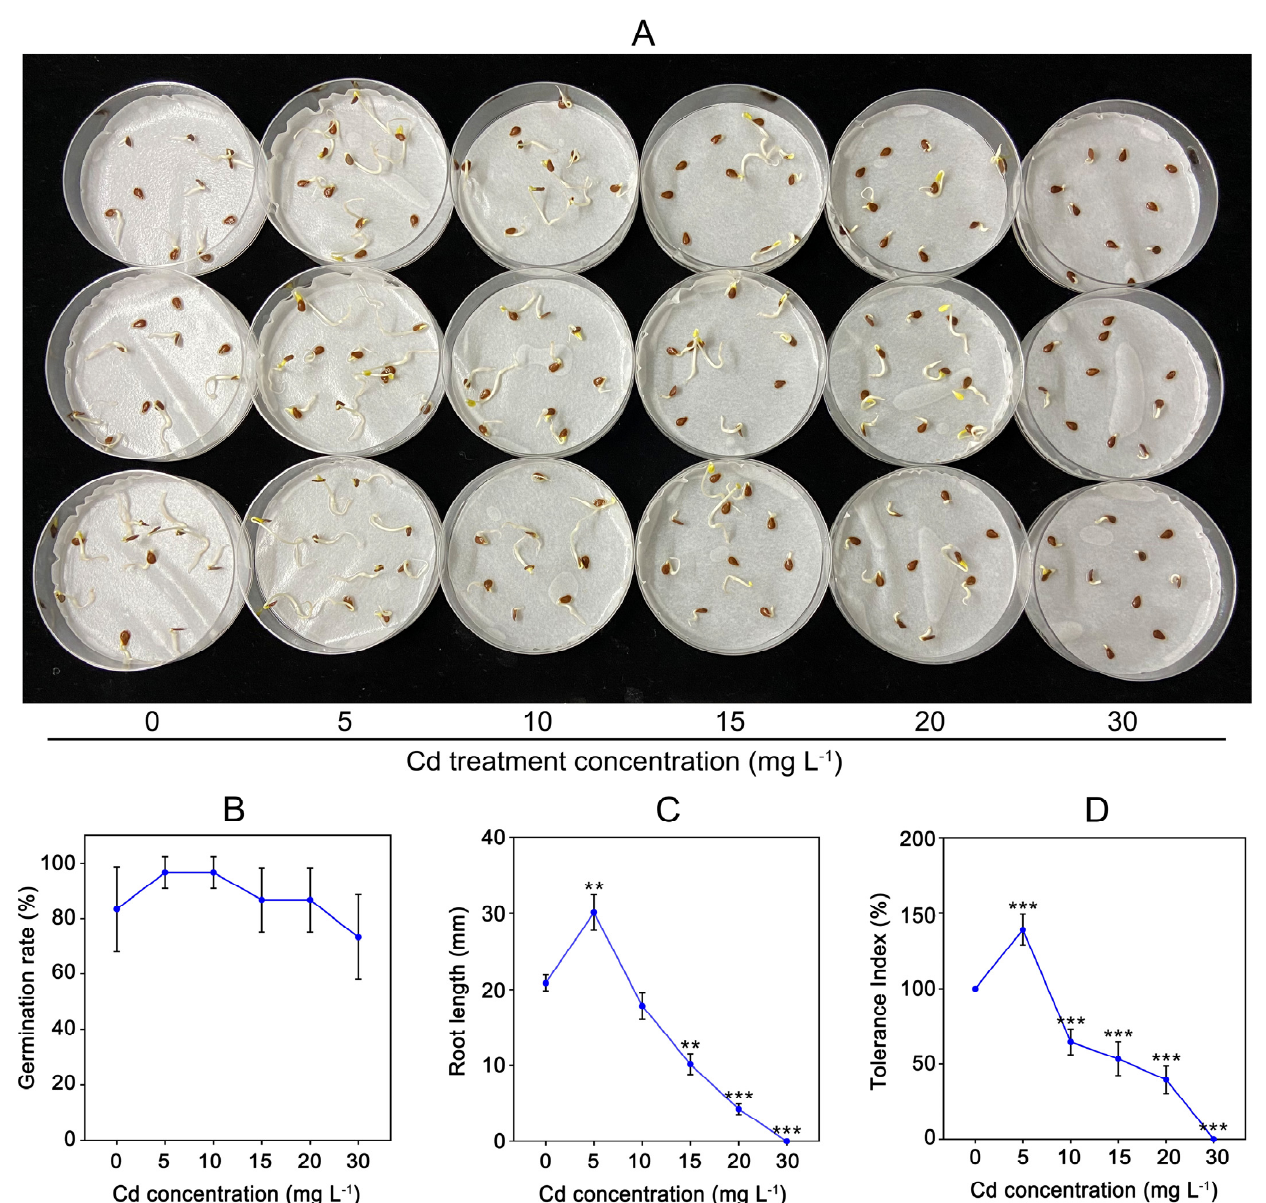
Figure 1. The effect of Cd concentrations on seed germination of C. gigantea . ( A ) The germination of C. gigantea seeds under different Cd concentrations treatment. ( B ) Seed germination rate under different Cd concentrations. ( C ) The root length under different Cd treatments. ( D ) Tolerance index under different Cd concentrations. Data represent the means ± standard deviations (n = 3); independent sample t test is performed between Cd treatment and control samples; ** 0.001 < p < 0.01, *** p < 0.001 (B − D).